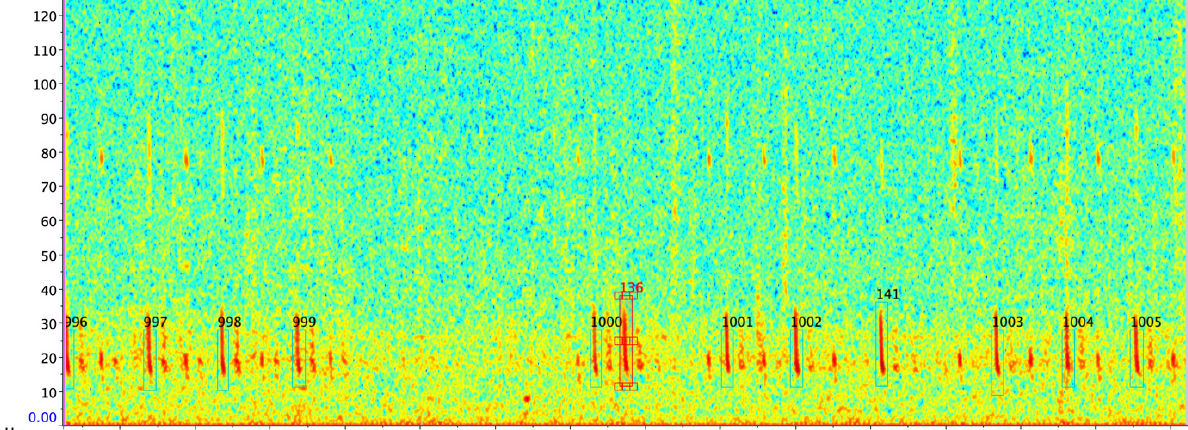
Figure A3. F20P log examples from file Balleny20150325_130000 for the location Balleny Island.